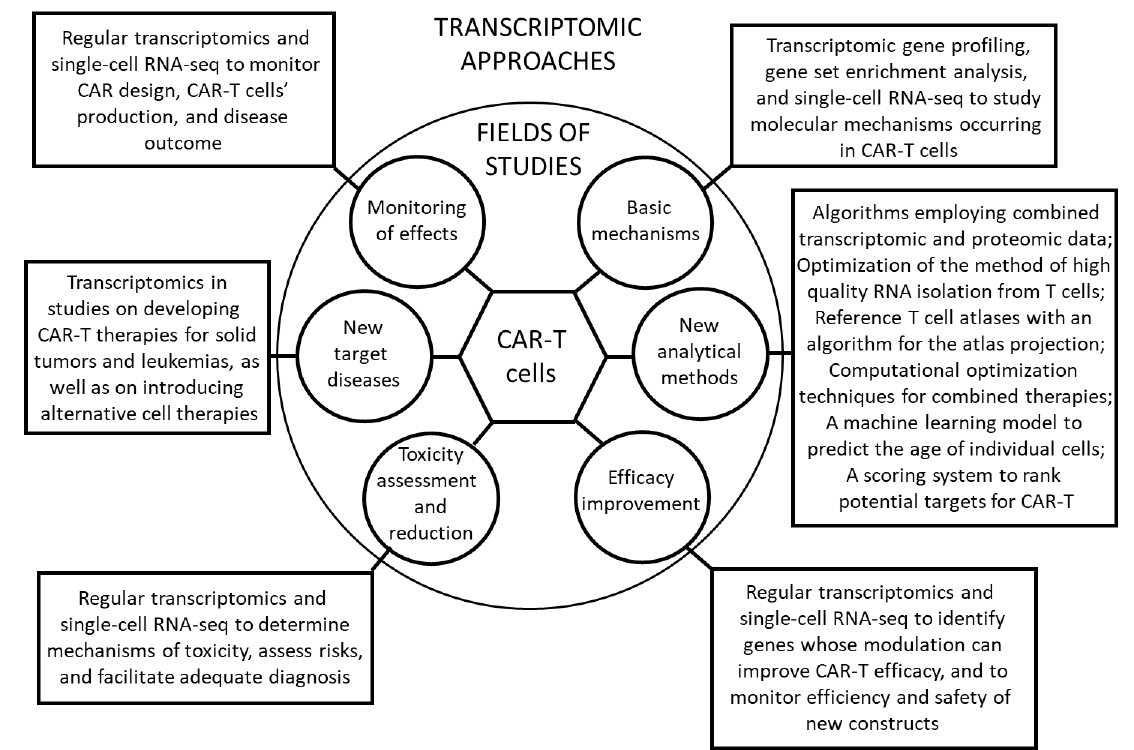
Figure 1. Schematic representation of the various possibilities of applications of transcriptomic methods in studies on and practical use of CAR-T cells, reported to date in the literature, as depicted in the form of the Cyske rosette chart (a kind of the schematic summary as proposed by Cyske et al. [85]).